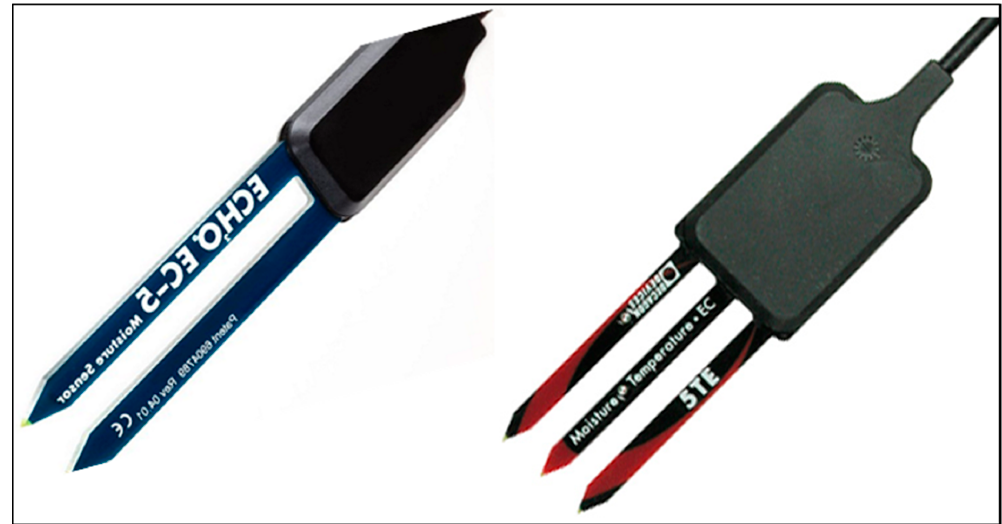
Figure 2. Prongs of the EC5 ( left ) and 5TE ( right ) sensors. The EC5 has two prongs while 5TE has three prongs. The length of these prongs is 5 cm.